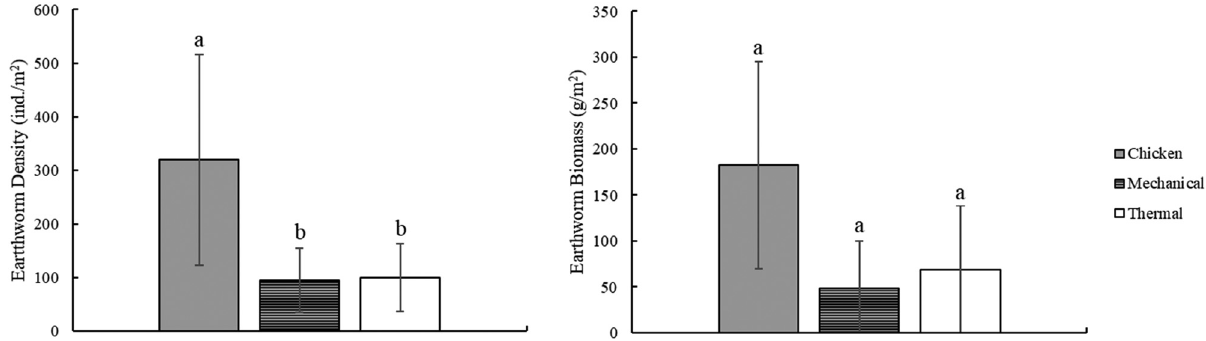
Figure 4: Earthworms ’ density ( individuals/m 2 ) and biomass ( g/m 2 ) , for each treatment, at the horticultural fi eld ( mean ± standard deviation ) . Di ff erent small letters mean statistical di ff erences between treatments ( Kruskal – Wallis test combined with Dunn ’ s multiple comparisons test; p - value < 0.05 )